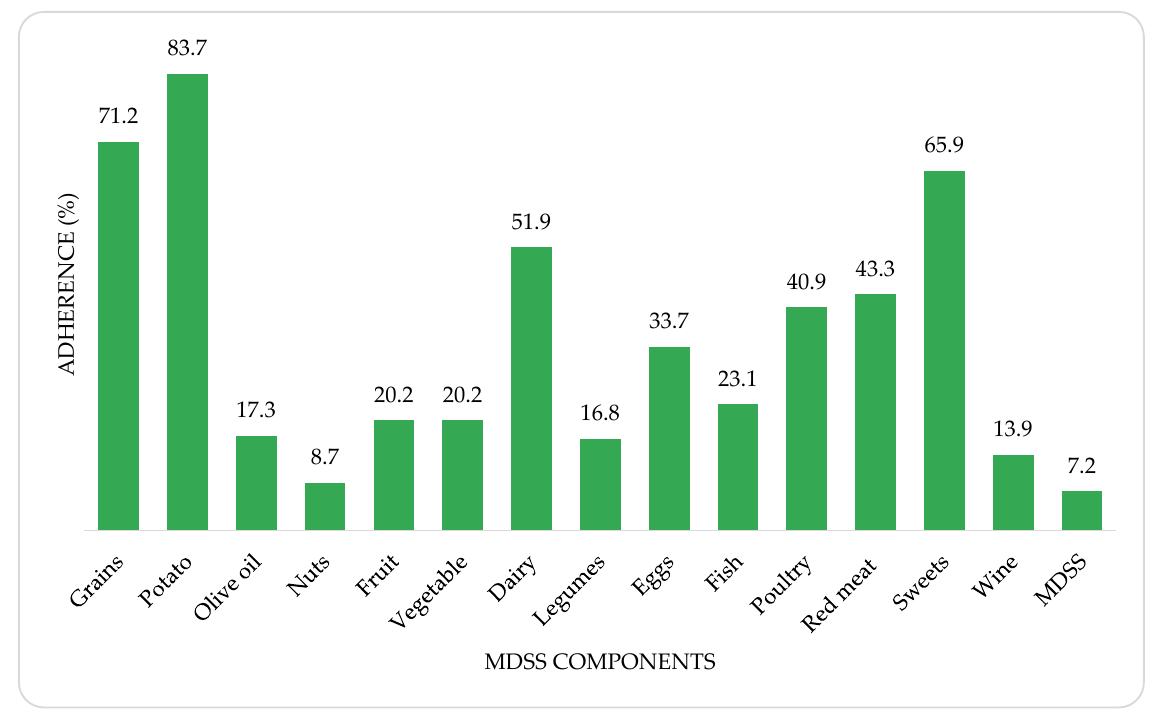
Figure 2. Adherence to the MeDi and its components among all study population.